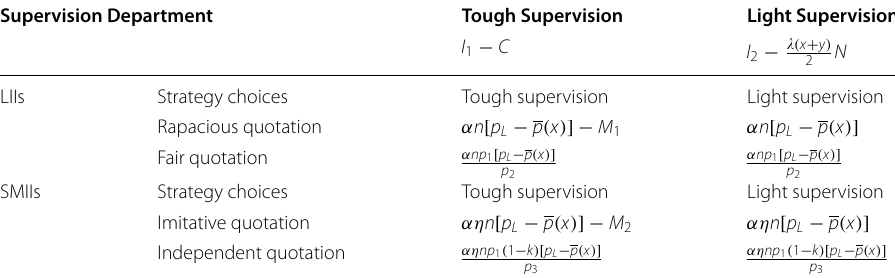
Table 2 Return matrix under different strategy choices Supervision